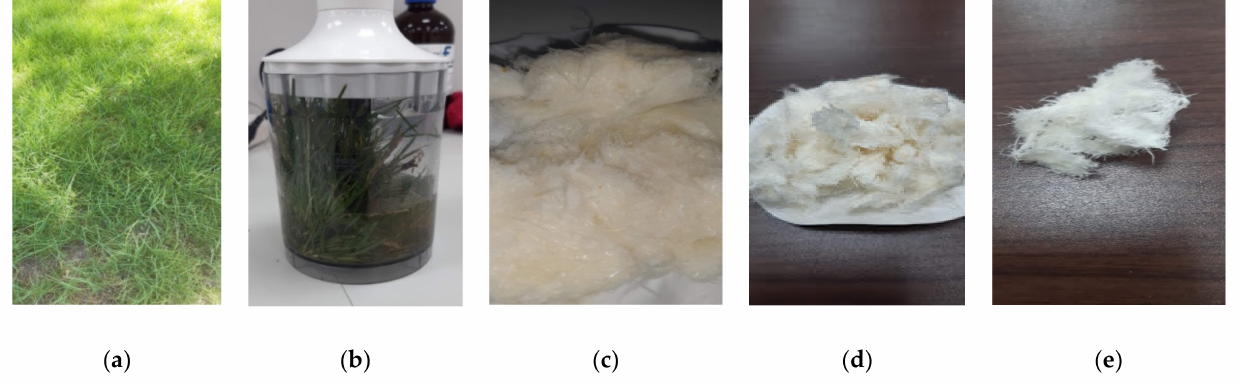
Figure 1. Preparation of cellulose from grass by sodium hypochlorite. ( a ) Type of grass, ( b ) mechanical cutting with NaClO, ( c ) after treatment, ( d ) after dying, and ( e ) after treatment by ultrasound